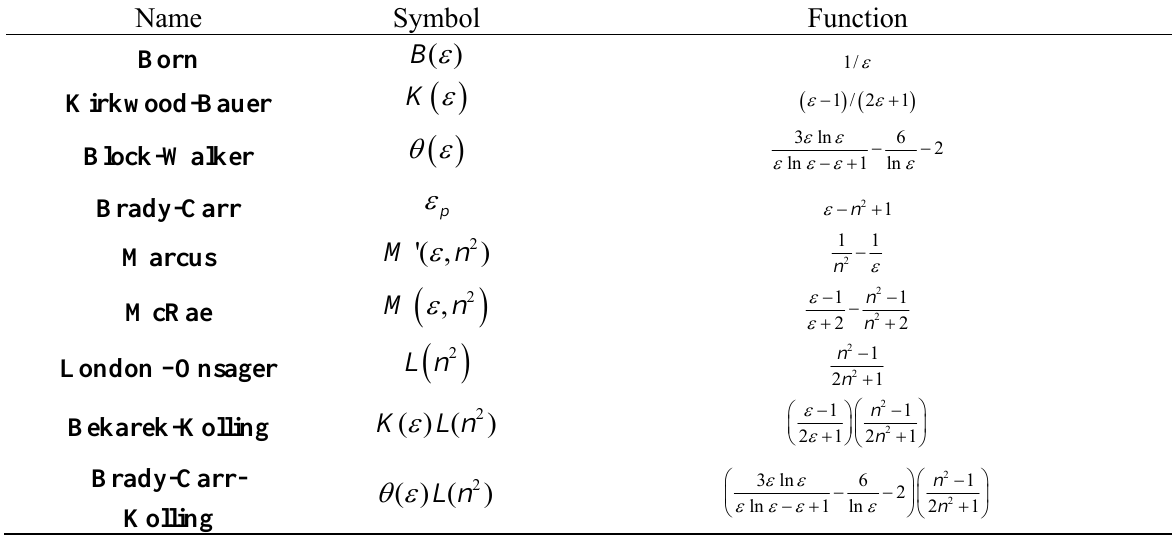
Table 1 Defining functions for the MO reaction field of the solvent in dielectric constant ( ) ε and/or ( ) n refractive index